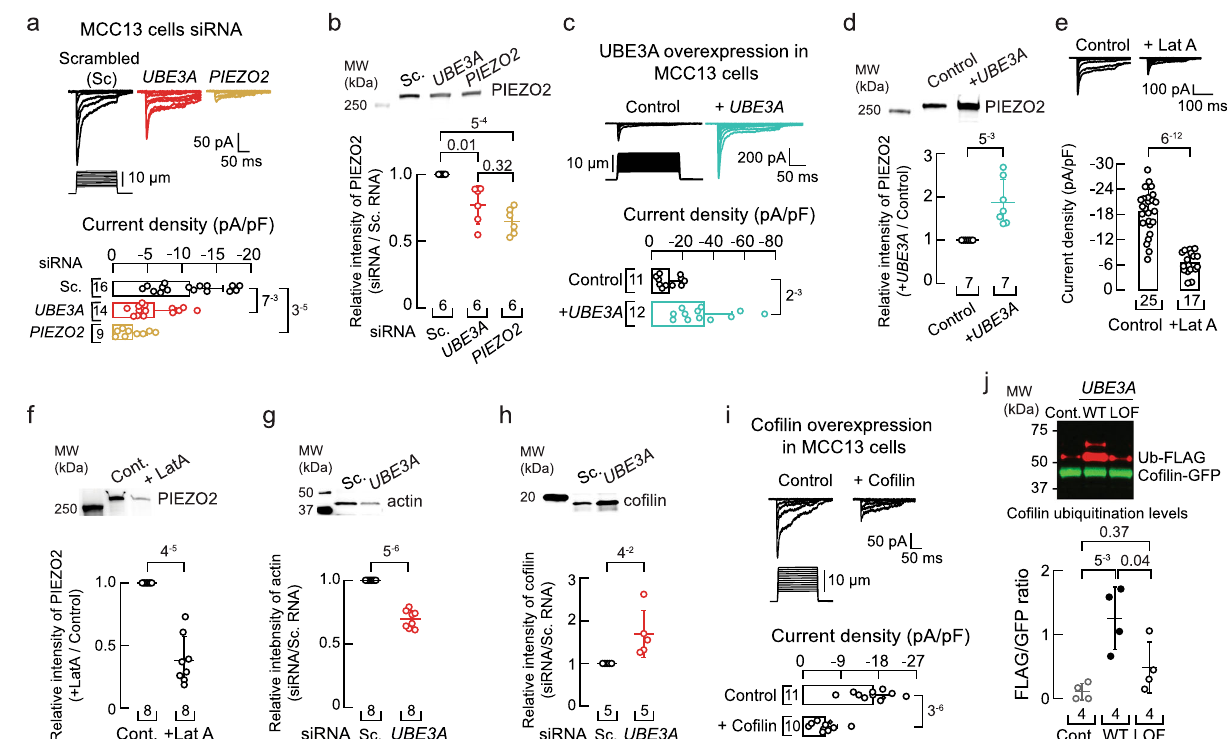
Fig. 2 | UBE3A knockdown increases co fi lin and decreases F-actin content and PIEZO2 function. a Top, representative whole-cell patch-clamp recordings of currents elicited by mechanical stimulation ( − 60 mV) in MCC13 cells transfected with scrambled, UBE3A , or PIEZO2 siRNAs. Bottom, current densities elicited by maximum displacement of siRNA-transfected cells. Bars are mean±SD. Kruskal- Wallis (H=18.76; p =8.4 − 5 ) and Dunn ’ s multiple comparisons test. b Top, western blot (anti-PIEZO2) of the membrane fractions of MCC13 cells transfected as in (a). Bottom, mean/scatter-dot plot showing relative intensities of PIEZO2 protein nor- malized to PIEZO2 in the Sc. group. Lines are mean±SD. Kruskal-Wallis (H=12.78; p =0.0017) and Dunn ’ s multiple comparisons test. c Top, currents elicited by mechanical stimulation ( − 60 mV)in cells transfectedwith UBE3A plasmid. Bottom, current densities elicited by maximum displacement of UBE3A transfected cells. Bars are mean±SD. Two-tailed unpaired t- test with Welch ’ s correction ( t =3.9). d Top, western blot (anti-PIEZO2) of the membrane fractions of MCC13 cells transfected with UBE3A plasmid. Bottom, mean/scatter-dot plot showing relative intensitiesofPIEZO2proteinin UBE3A transfectedcellsnormalizedtoPIEZO2inthe control group. Lines are mean±SD. Two-tailed one-sample t -test ( t =4.4). e Top, currents elicited by mechanical stimulation ( − 60 mV) of latrunculin A (1 µ M; 24h)- treatedMCC13cells.Bottom,currentdensitieselicitedbymaximumdisplacement. Bars are mean±SD. Two-tailed unpaired t -test with Welch ’ s correction ( t =9.9). f Top,westernblot(anti-PIEZO2)ofthemembranefractionsofMCC13cellstreated